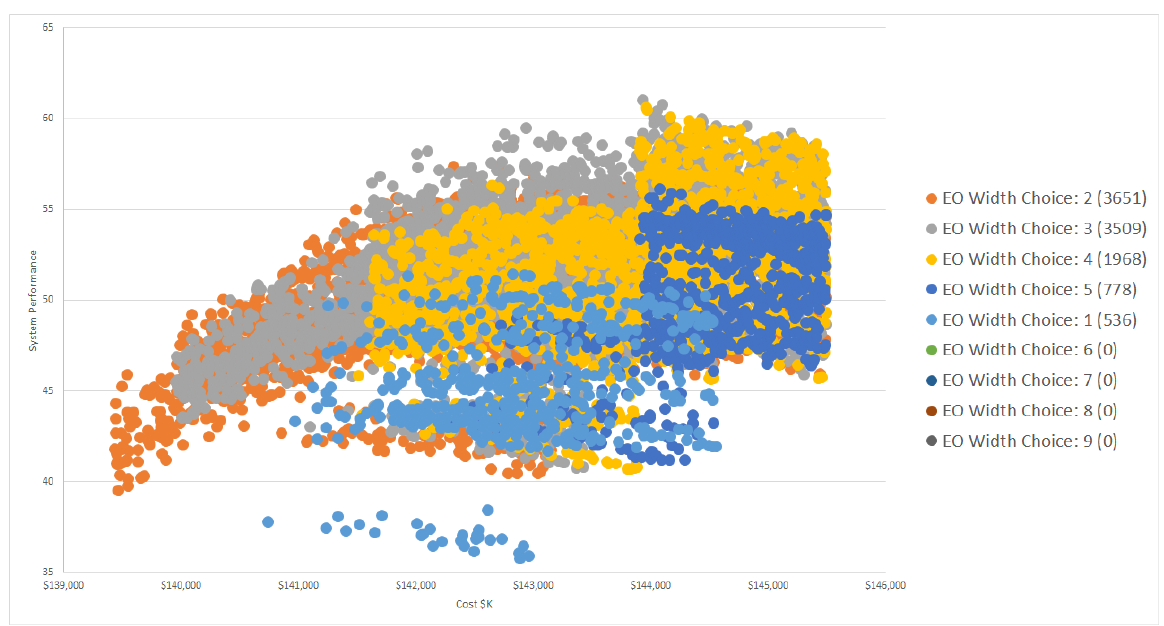
Figure 14. First Revised UAV Tradespace with Electro-Optical Sensor Width Choice as Set Driver.